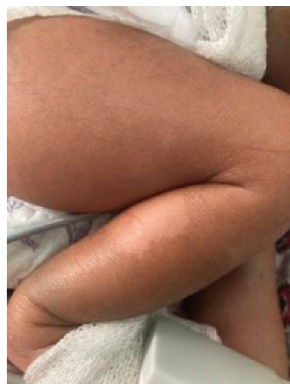
Figure 3: Skin desquamation on the right leg. Figure 1: A pus-draining lesion on the scalp and skin desqua-